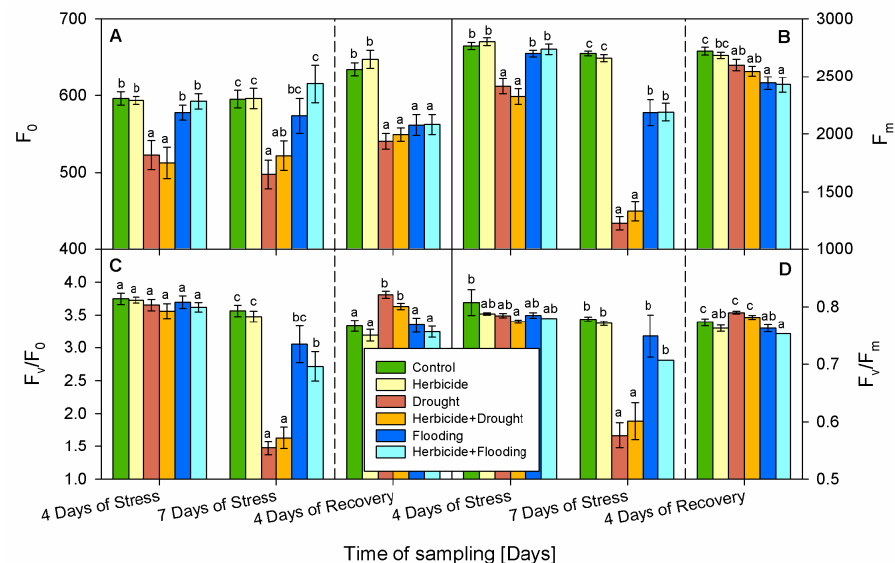
Figure 4. Chlorophyll fluorescence parameters (( A ): F 0 ; ( B ): F m ; ( C ): F v /F 0 ; ( D ): F v /F m ) of wheat plants treated with herbicide and subjected to drought or flooding stress. Data are mean values ± standard errors. Different small letters denote significant differences between mean values at p < 0.05.